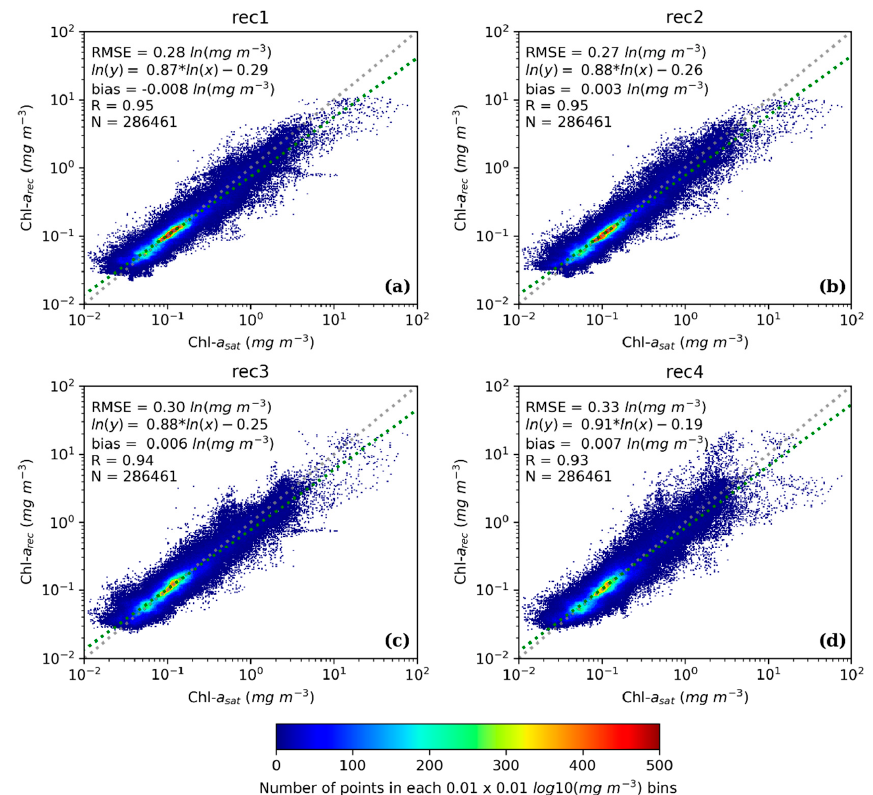
Figure 8. Scatterplots of the CV-data (Chl- a sat ) versus the corresponding modeled data (Chl- a rec ) for the four reconstruction schemes. Color scale indicates the number of points in each 0.01 * 0.01 log10 (mg m − 3 ) bin. Green dotted lines represent the best fit line and the grey dotted lines represent the 1:1 line.